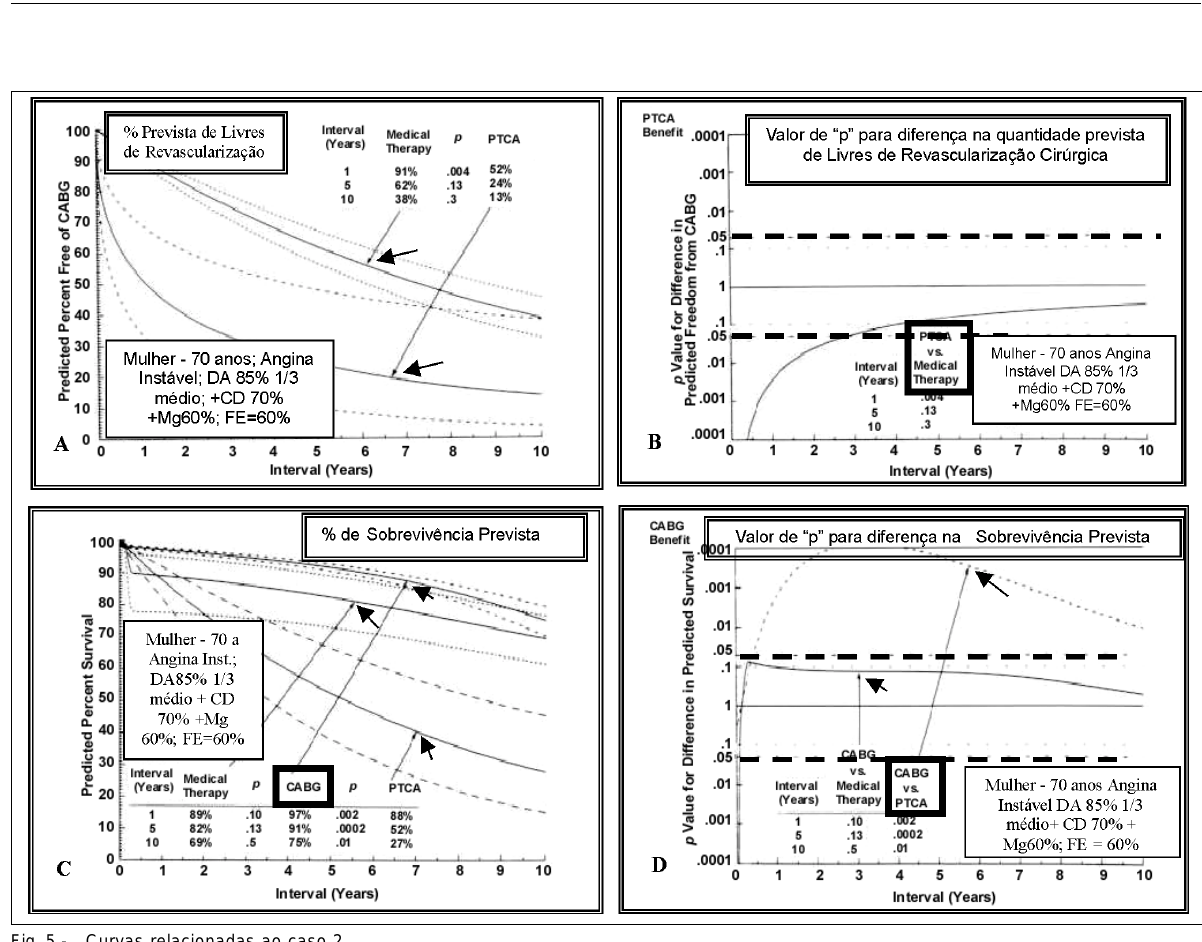
Fig. 5 - Curvas relacionadas ao caso 2. (Fonte: Kirklin J W & Barrat-Boyes B G. Cardiac surgery. 2.ed. New York: Churchill Livingstone, 1993. v.1).